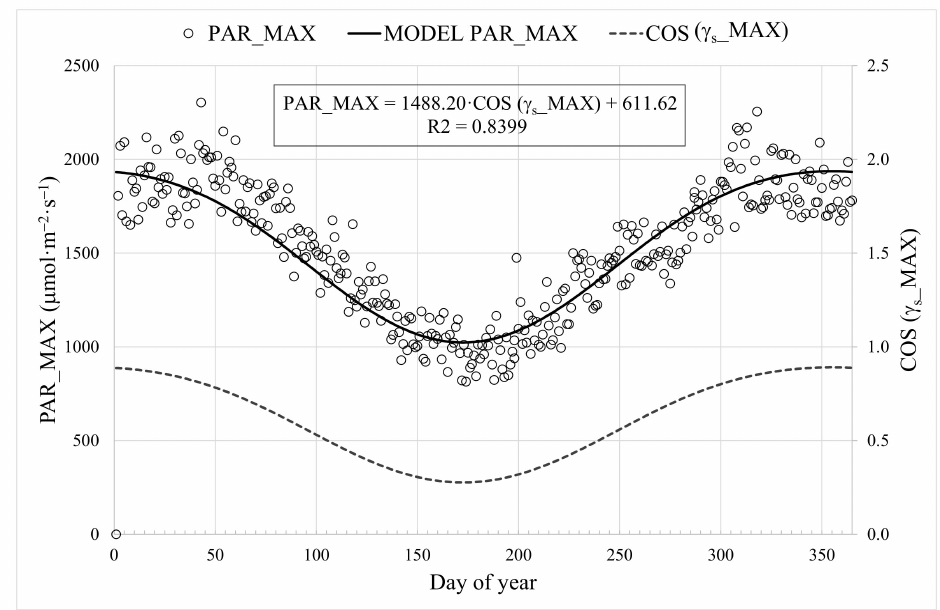
Figure 4. Correlation between experimental maximum PAR (PAR_MAX) and cosine of maximum solar altitude angle (cos ( γ s _MAX)).